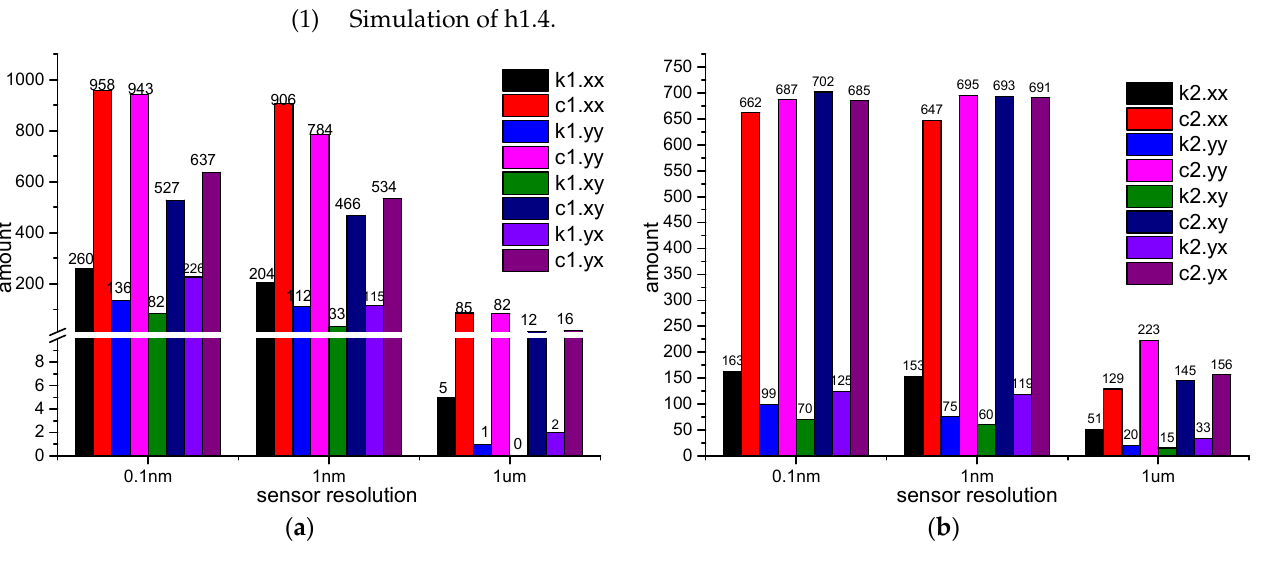
Figure A11. Statistical results of the amount of the frequencies, at which the related error is less than 10% and the absolute value is less than 10: ( a ) #1 bearing; ( b ) #2 bearing.